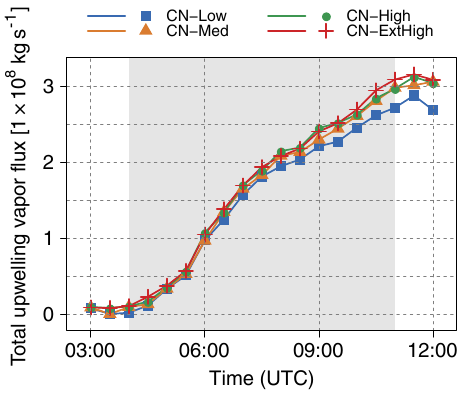
Figure 9. Total upwelling vapor flux at the cloud base as a func- tion of time for the CN-Low (blue), CN-Med (marigold), CN-High (green) and CN-ExtHigh (red) experiments. The shaded area in grey represents the time period that the entire MCS is within the grid do-